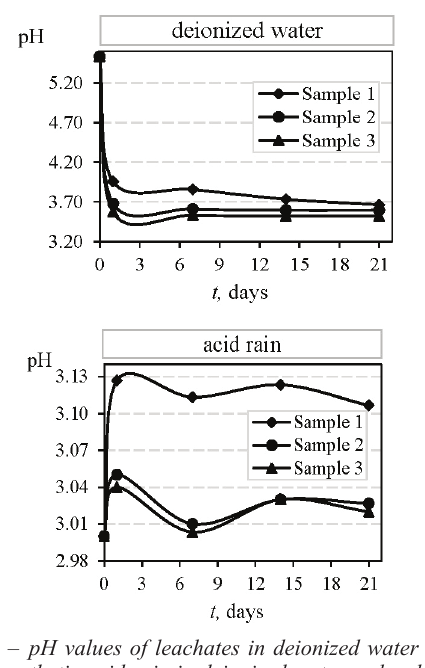
Fig. 1 – pH values of leachates in deionized water and syn- thetic acid rain in deionized water as leachant